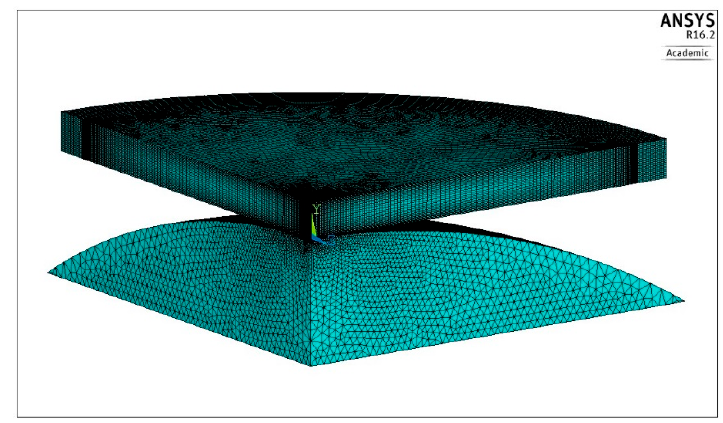
Figure 6. Shape of the modeled body and the finite element mesh.